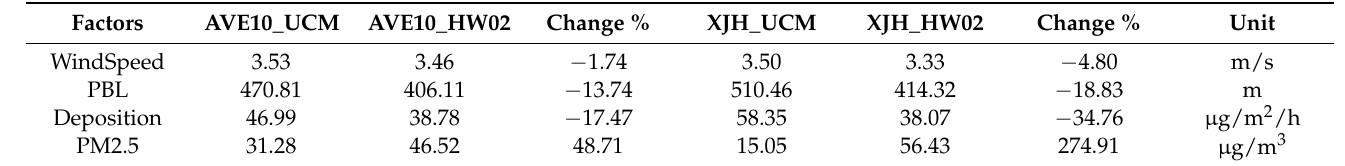
Table 4. Time-dependent change of modeling results between the base scenario and the HW02_scenario at the Xujiahui Monitor Station and ten monitor stations from 5–15 July